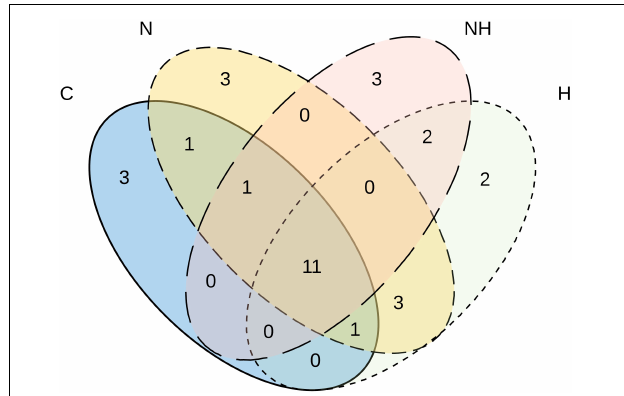
FIGURE 4 | Venn diagram showing the number of unique and shared morphotypes of fungal endophytes in the leaves of greenhouse-cultivated aspen ( Populus tremula ) plants untreated control plants (C) and plants subjected to nitrogen addition (N), herbivory (H), or nitrogen addition and herbivory in combination (NH) ( n = 24 plants per treatment).